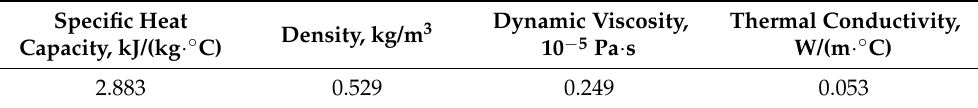
Table 4. Model Compound (Hot Fluid) Properties of the First-Stage Condenser at the Qualita- tive